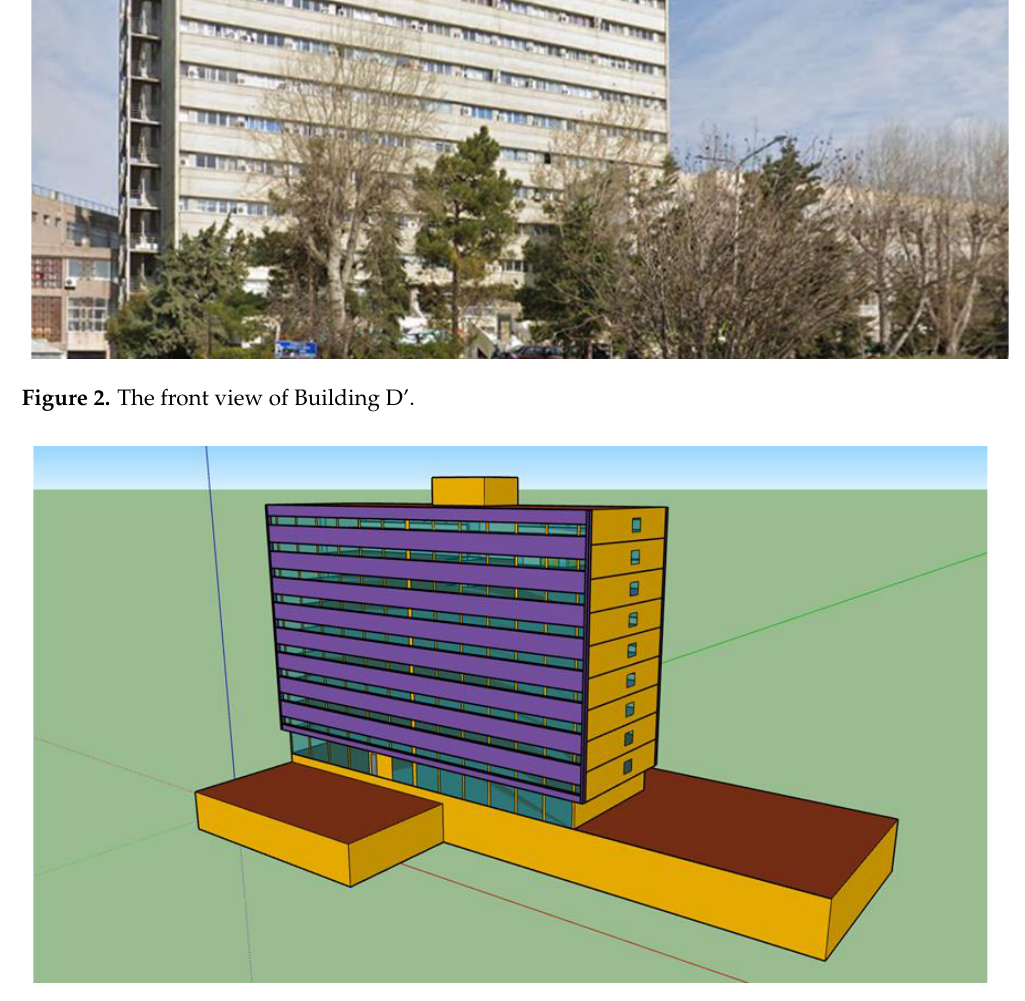
Figure 3. The 3D view of the simulated building.